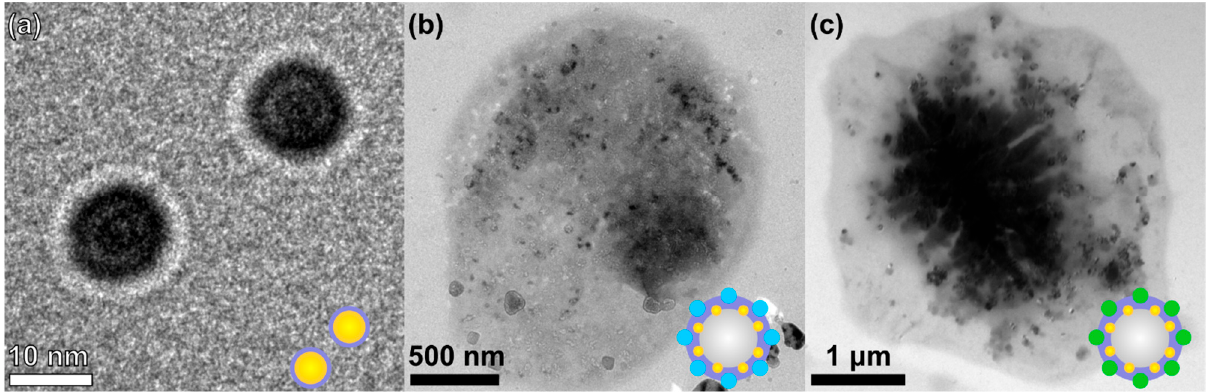
Figure 3. TEM images of ( a ) AuNPs coated with BSA shell, ( b ) dried BSA-ZnPc-AuNPs MBs sample, and ( c ) BSA-ICG- AuNPs MBs.